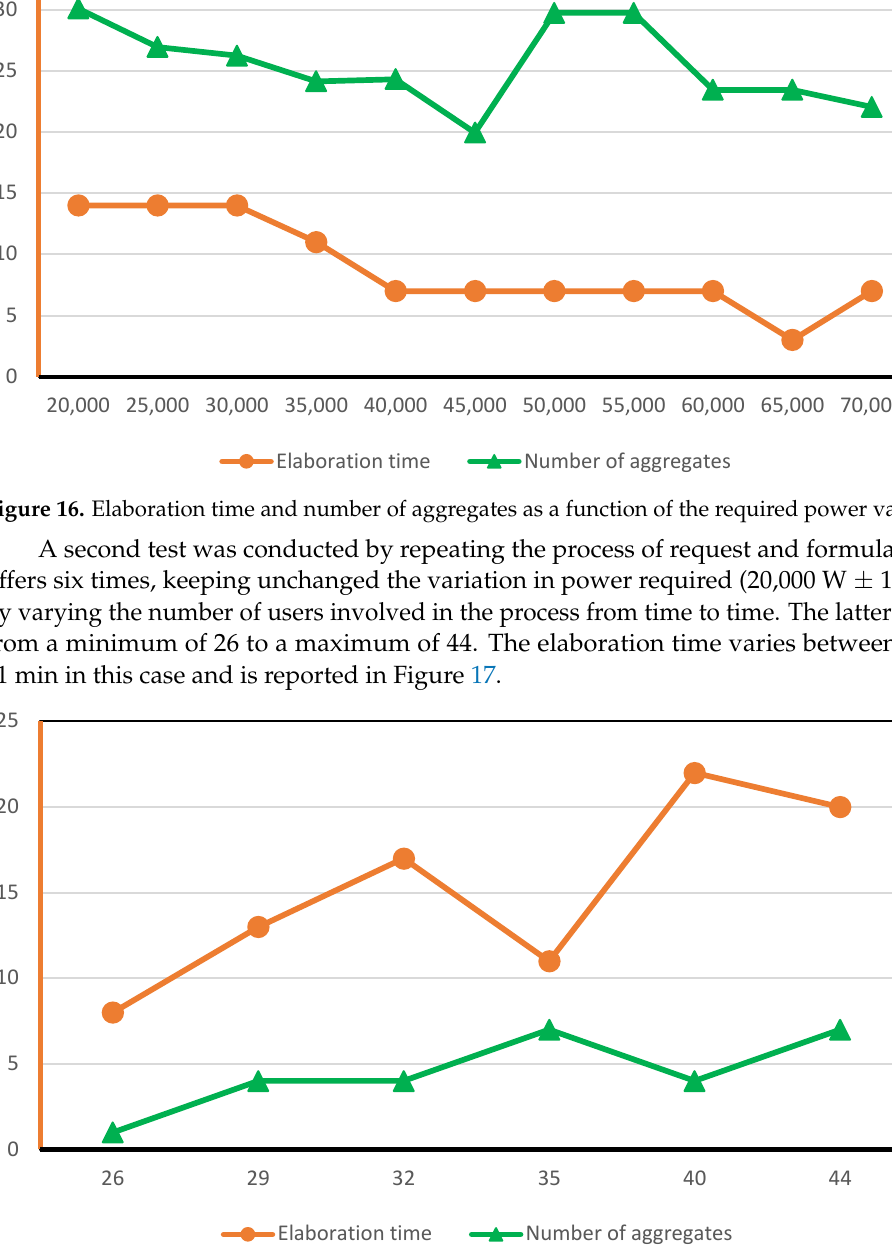
Figure 17. Elaboration time and number of aggregates as a function of the number of prosumers participating in the aggregation process.